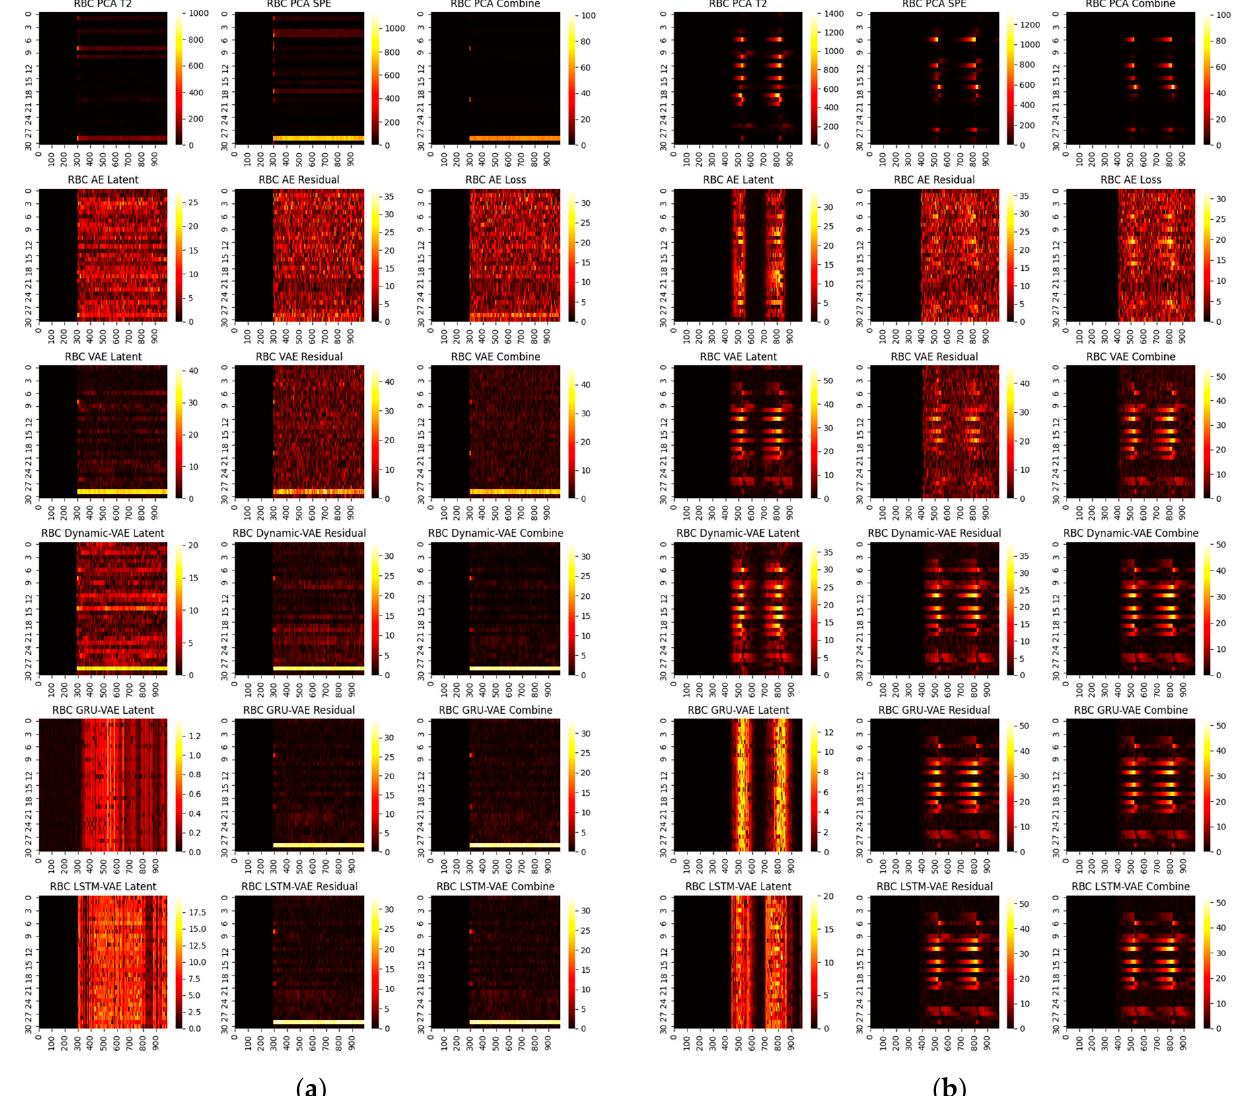
Figure 8. RBC contribution plots for small faults: ( a ) fault 4, ( b ) fault 20.